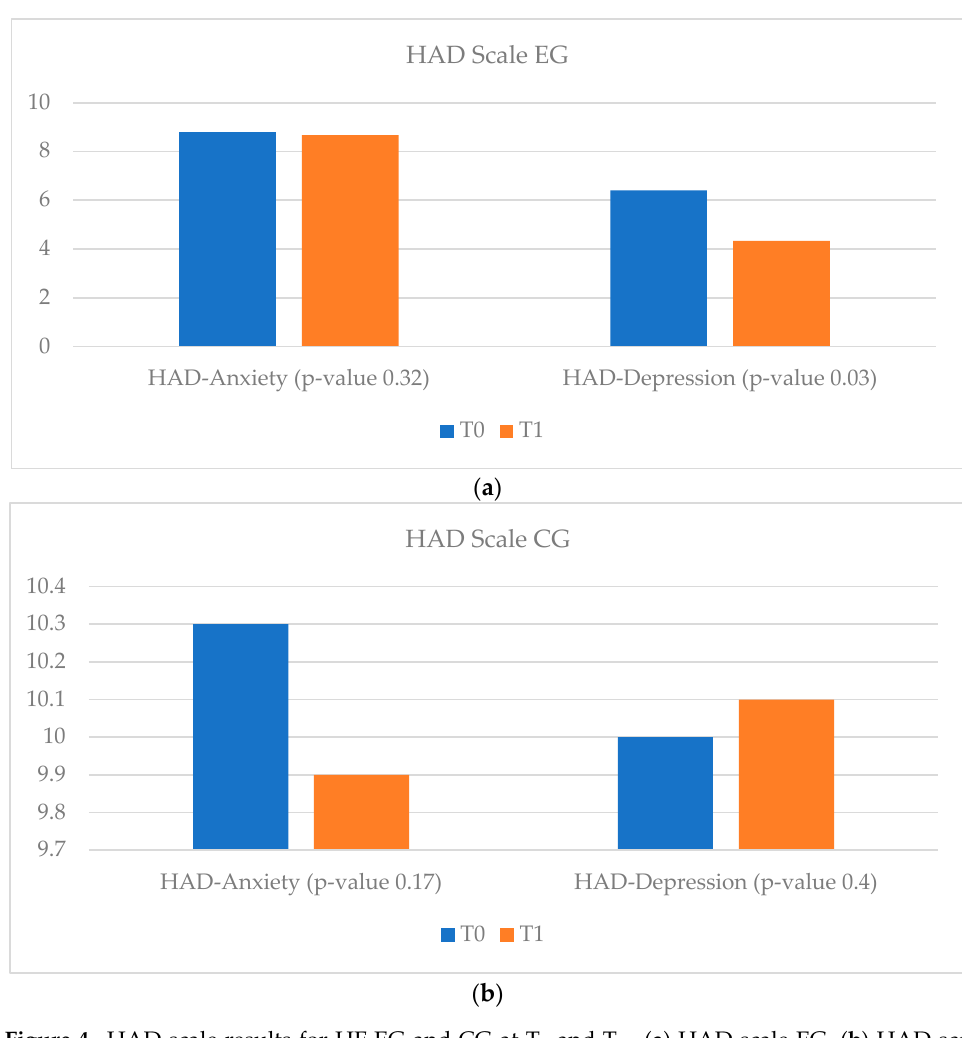
Figure 4. HAD scale results for HF EG and CG at T 0 and T 1 . ( a ) HAD scale EG. ( b ) HAD scale CG. HAD = hospital anxiety and depression scale; HF= heart failure; EG = experimental group; CG = control group; T 0 = before the rehabilitation period; T 1 = after the rehabilitation period.